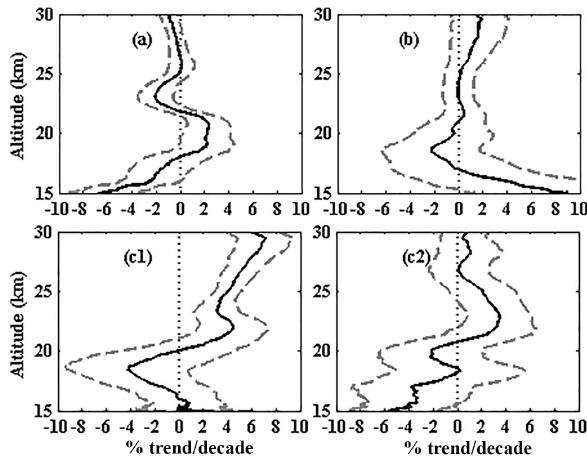
Figure 15. Vertical profiles of ozone decadal trends derived by the Trend-Run model from 15 to 30km at the Equator (a) , tropics (b) , Reunion (c1) and Irene (c2) . Irene and Reunion are separated for this present case due to the lack of ozone profiles at the Irene sta- tion from January 2008 to October 2012. The Irene trend profile is derived based on ozone profiles recorded from January 1998 to December 2007 (10